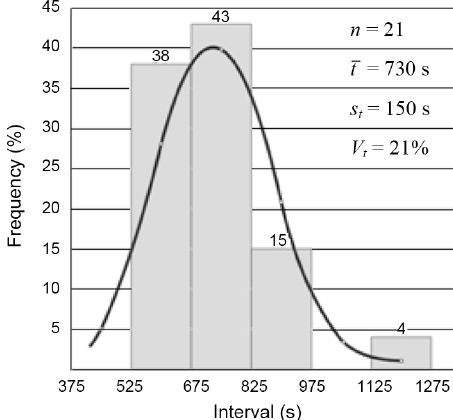
Fig. 5. The punching duration histogram, normal distribution curve and statistical data of the reinforced concrete ring